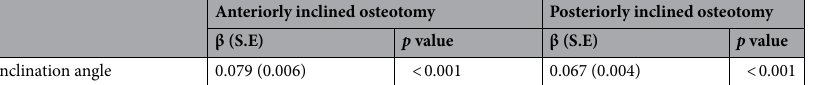
Table 6. Analysis of the effect of sagittal osteotomy inclination angle on the change in the posterior tibial slope by linear mixed model. The coefficients were obtained from a linear mixed model under a random intercept model with first order autoregressive structure. S.E. = standard error.